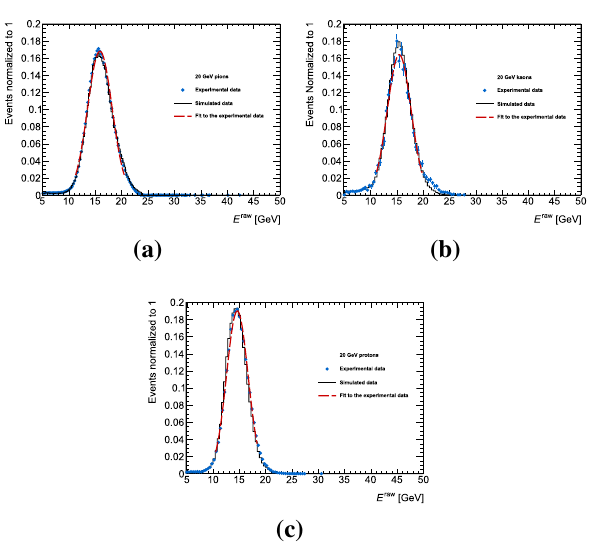
Fig. 19 Distributions of the reconstructed energy E raw obtained ana- lyzing pion ( a ), kaon ( b ) and proton ( c ) data with E beam = 30 GeV. The blue dotted histograms represent the experimental data. Only statistical uncertainties are shown. The dashed curves in red correspond to the fit of a Gaussian function to the experimental data in a region ± 2 σ around the peak value. The black histograms correspond to the predictions of the MC